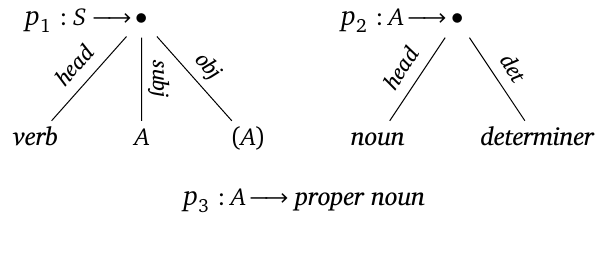
Over-approximating regular tree